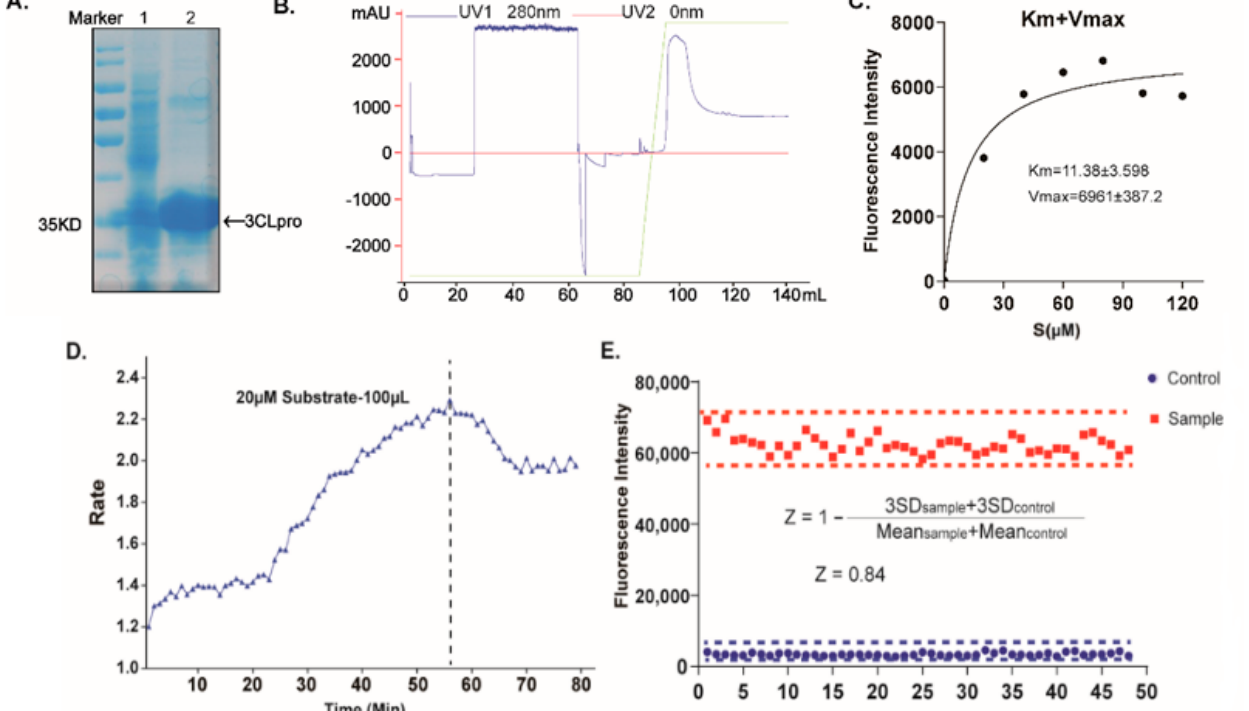
Figure 1. Establishing a high-throughput screening system with FRET assay. ( A ) SDS–PAGE analysis of the 3CL pro . Lane 1 represents the molecular mass markers, 35 kDa. Lane 2 shows the cell lysate, and lane 3 shows the 3CL pro with the tag, respectively. ( B ) Purification flow-through curve. ( C ) Measurements of kinetic parameters of the 3CL pro . ( D ) Dependence of the 3CL pro reaction rate on the reaction time. ( E ) Summary of statistical parameters to assess the robustness of the HTS assay.